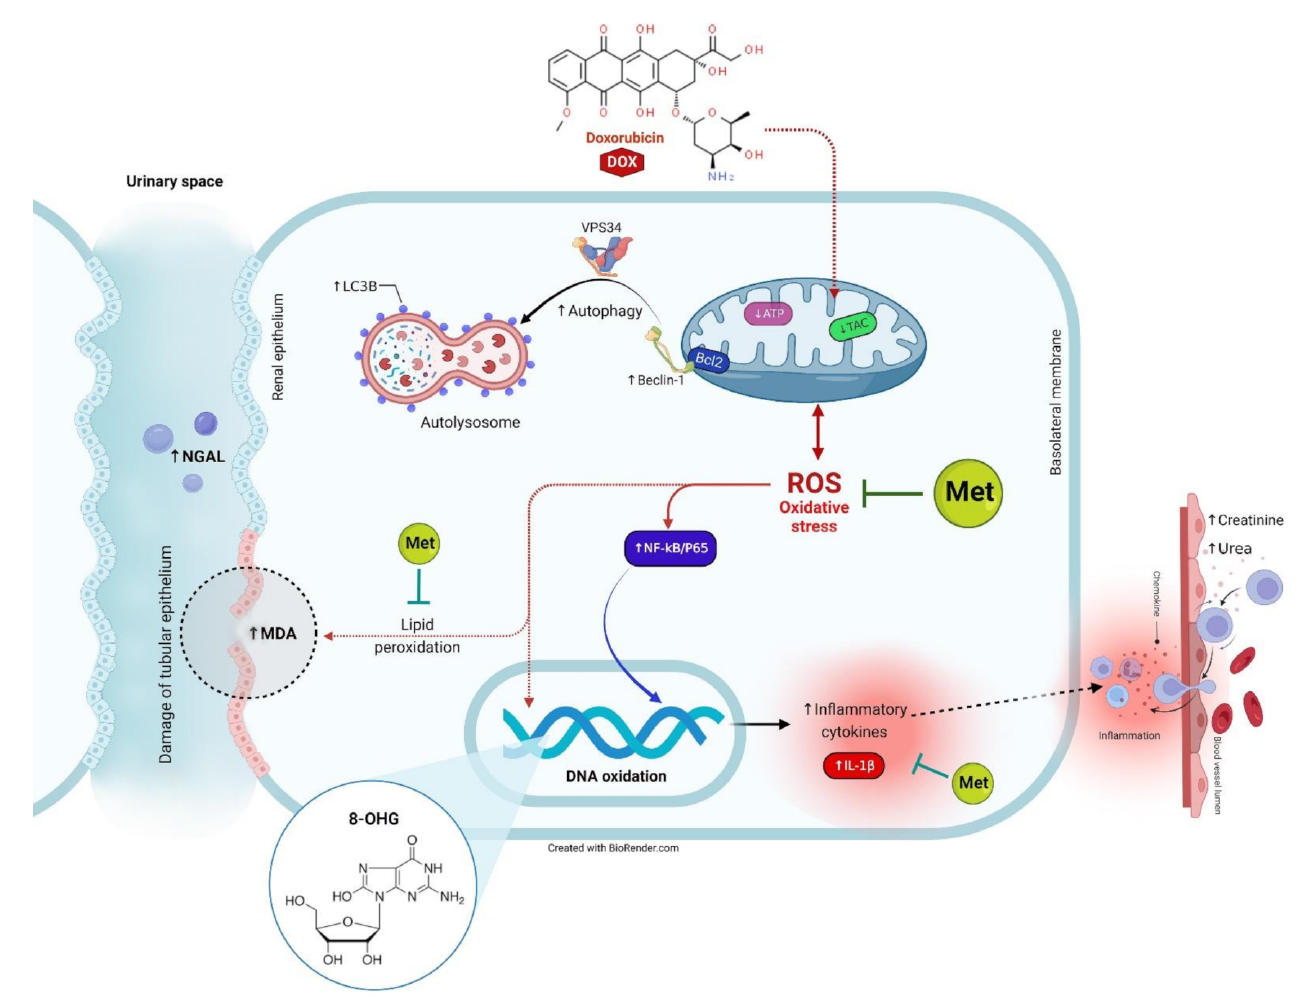
Figure 9. The proposed mechanisms located behind the protective effect of Met against DOX-induced renal